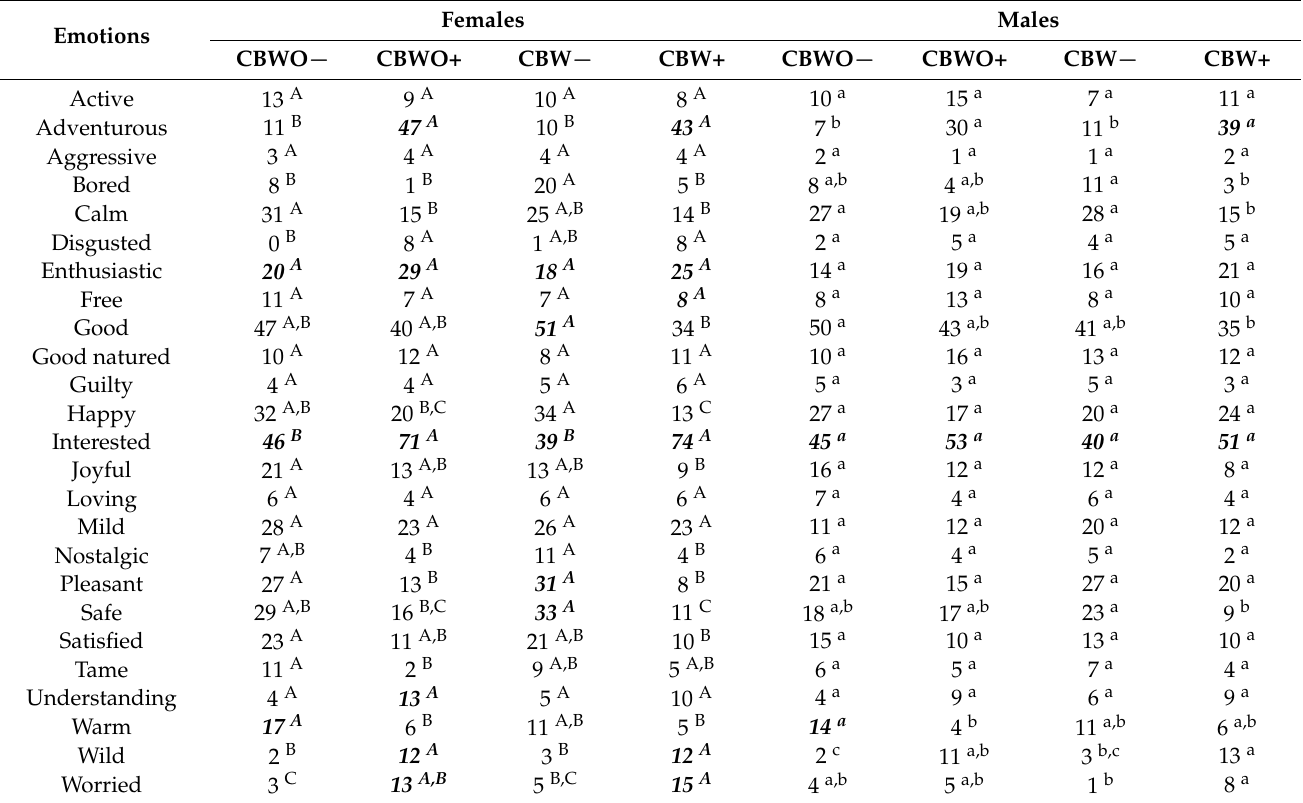
Table 3. Emotional profile † elicited by treatments ‡ in the before-tasting